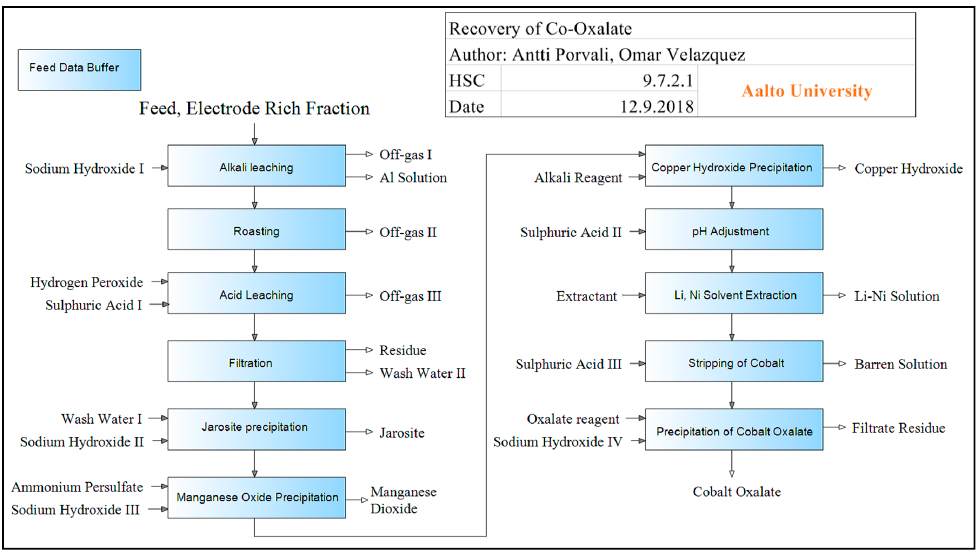
Figure 6. HSC Sim ® simulation flowsheet of the hydrometallurgical process described by [9]. In a similar way, the hydrometallurgical process was simulated in HSC Sim ® varying the feed material from the “electrode rich fractions” obtained by Aalto and CSU PP (Tables 1 and 2, respectively). Table 4 presents the recovery results per element according to the simulations of the hydrometallurgical process. Table 4. The percentage recovery of elements of interest. Obtained from the simulation with HSC Sim ® of the hydrometallurgical process.